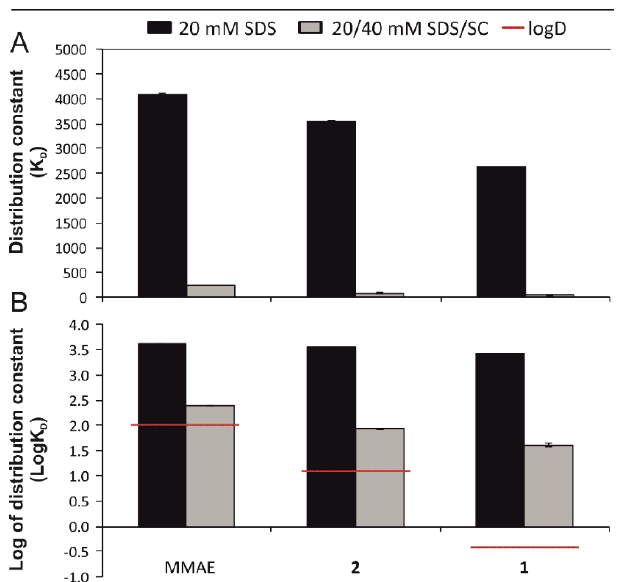
Figure 2. Distribution constants (displayed in 2A) and the logarithm of distribution constants (displayed in 2B) (including error bars) of MMAE, 1, and 2 by micellar electrokinetic chromatography (MEKC). Amounts of 20 mM sodium dodecyl sulfate (SDS) and 20 mM SDS mixed with 40 mM sodium cholate (SC) in sodium phosphate buffer (pH 7.4, I = 10 mM) were used as pseudostationary phases in MEKC. Thiourea was used as an EOF marker. Separation conditions were as follows: capillary length 30/38.5 cm; separation voltage 25 kV; capillary cassette temperature 25 °C; sample injection 10 s 10 mbar; UV detection at 200, 214, 238, and 254 nm. The inner and outer diameters of the capillary were 50 μm and 375 μm, respectively. The logD values represent the theoretically calculated distribution coefficients calculated by the ChemAxon software. Separations 2018 , 5 , x FOR PEER REVIEW